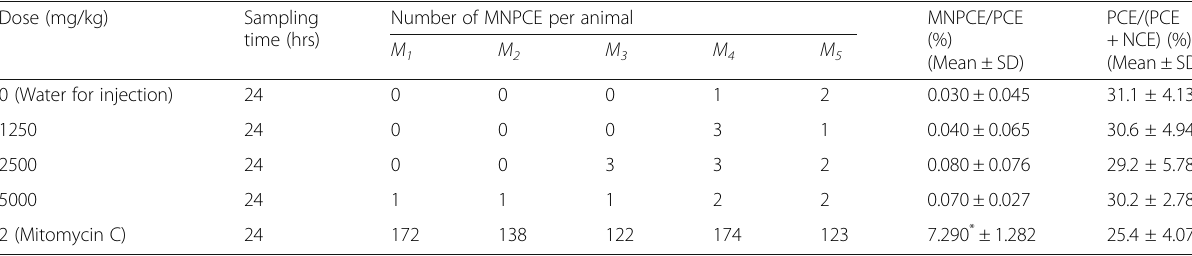
Table 3 Results of the in vivo micronucleus test for